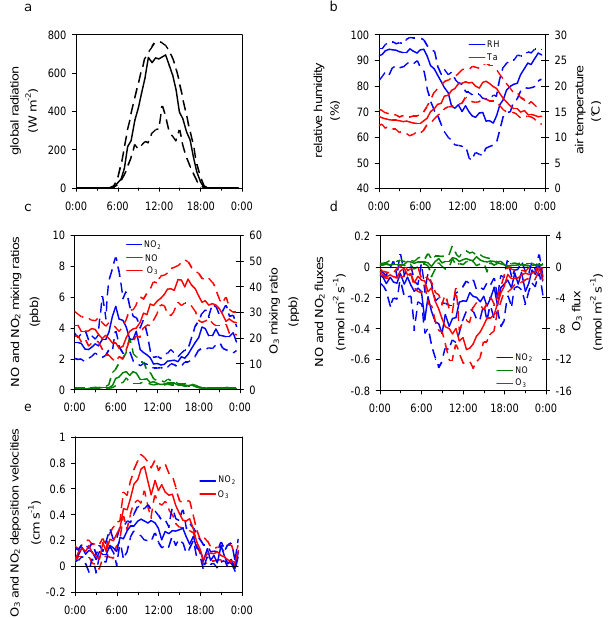
Figure 2: Diel courses of (a) global radiation, (b) air relative humidity (blue line) and temperature (red line), (c) nitrogen dioxide (blue line), nitric oxide (green line) and ozone (red line) mixing ratios at 1.65 m above ground level, (d) nitrogen dioxide (blue line), nitric oxide (green line) and ozone (red line) fluxes, and (e) deposition velocities for nitrogen dioxide (blue line) and ozone (red line) determined by EC from 29 August to 20 September 2005. Solid lines represent half hourly medians and dotted lines represent interquartile ranges. Fluxes were not corrected for chemical reactions. Only those data have been considered, for which footprint analysis indicated that at least 95 % of the fluxes have originated from the experimental field (see Fig. 3).